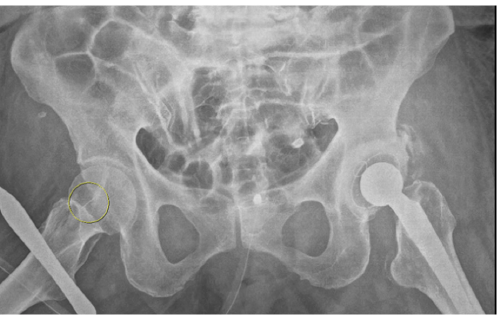
Figure 1. Radiography of pelvic bone. A needle fragment showed in the right groin (yellow circle).